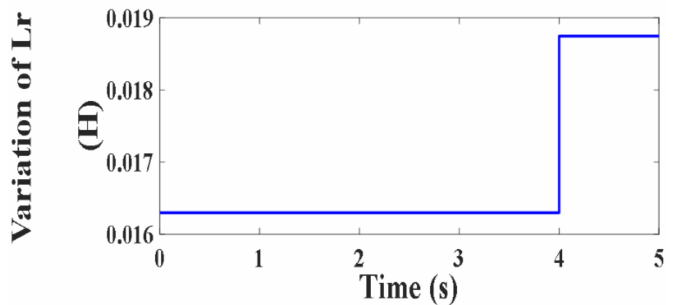
Figure 102. Variation of L r (H).